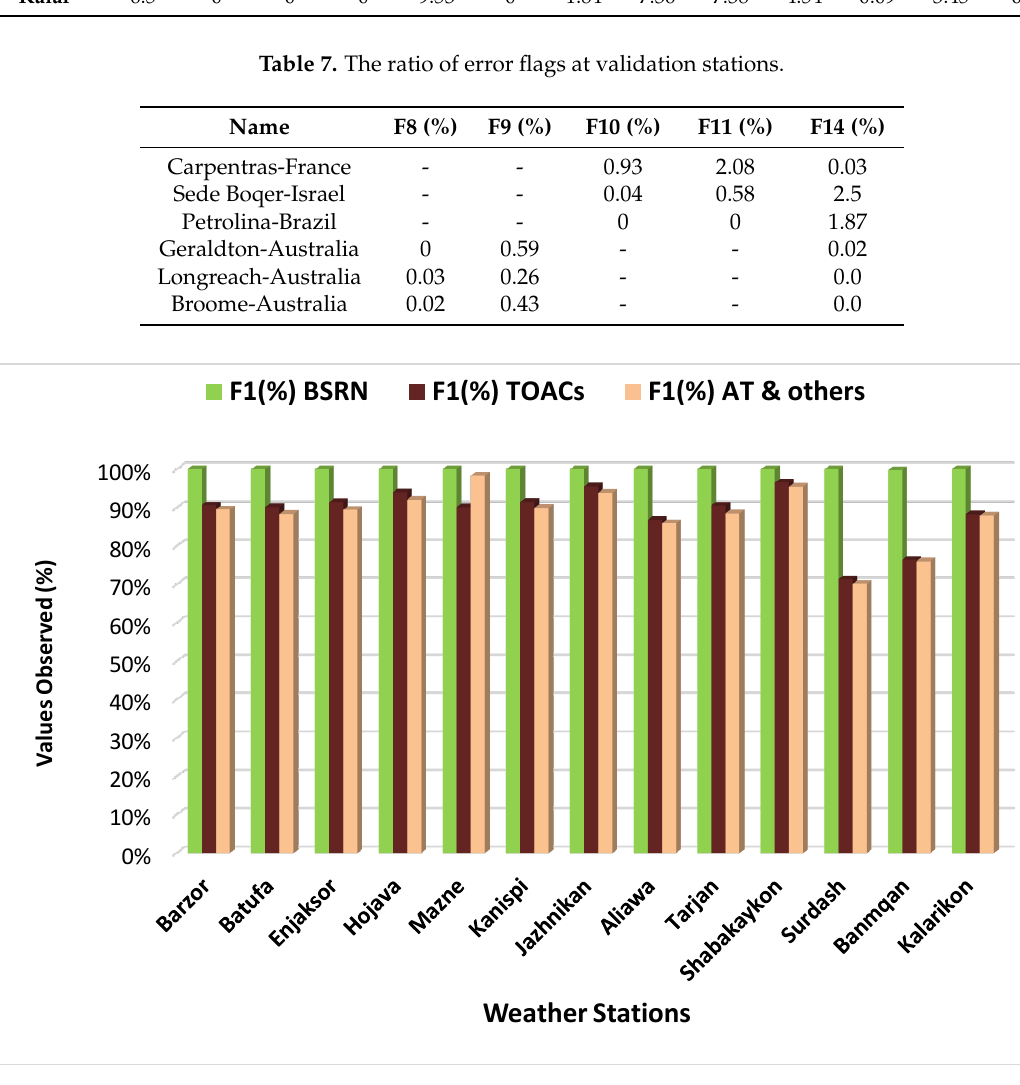
Table 6. The ratio of NA and error flags at automatic stations.